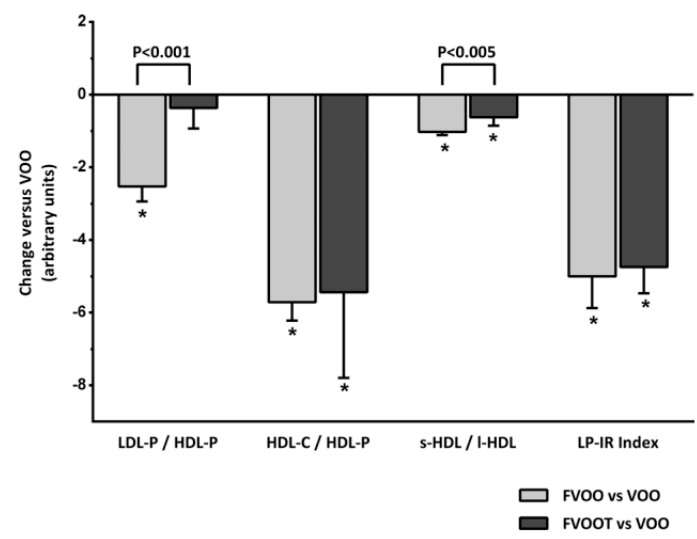
Figure 5. Changes in atherogenic lipoprotein particle atherogenic ratios and lipoprotein insulin resistance index (LP-IR) after consumption of functional olive oils versus natural virgin olive oil (VOO). FVOO: Functional virgin olive oil enriched with its phenolic compounds (500 ppm); FVOOT: Functional olive enriched with its phenolic compounds (250 ppm) and those from thyme (250 ppm). *, P < 0.001 versus VOO. Differences between functional olive oils are indicated by square brackets with the corresponding significance. Figure reproduced with permission from Fernández-Castillejo et al. [34]. HDL: high-density lipoprotein; HDL-C: HDL-cholesterol; LDL-P: low density lipoprotein-particles; HDL-P: HDL-particles; s-HDL: small HDL; l-HDL: large HDL.